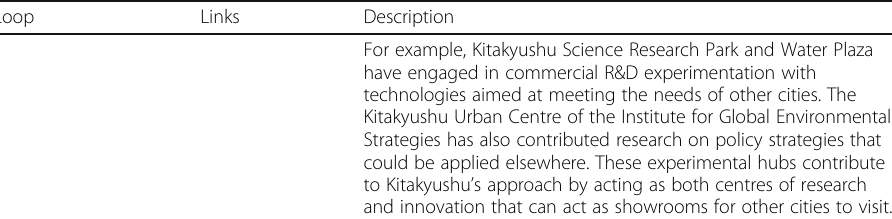
Table 5 Explanation of feedback loops from city-city collaboration shown in Fig. 3. Internal success attracted the attention of other cities in the region